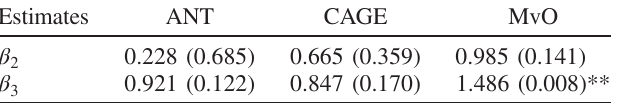
DOES CONFIDENCE IN A WRONG ANSWER parentheses) for the logistic regression model for RANDC ∶ yes as predicted by confidence on ANT:TRACE, CAGE, and MvO: ONE. Only one p value was significant (marked with asterisks).